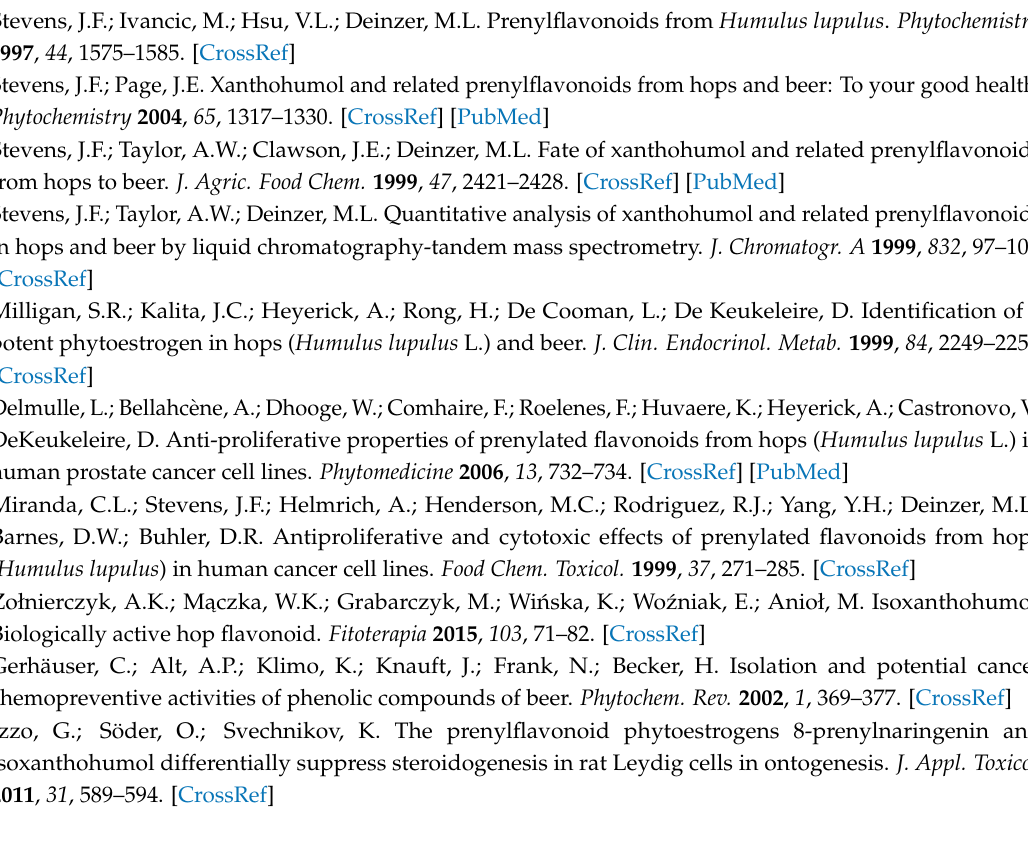
Supplementary Materials: The following are available online, Figures S1–S18: 1D, 2D-NMR spectra of isoxanthohumol ( 1 ) and metabolites 2 – 7 , Scheme S1: HPLC Profiles of oxygenated metabolites ( 2 – 7 ) of isoxanthohumol ( 1 ), Figure S19: High resolution ESIMS data of metabolites 2 – 7 , Figure S20: Circular dichroism (CD) profiles of metabolites 2 – 7